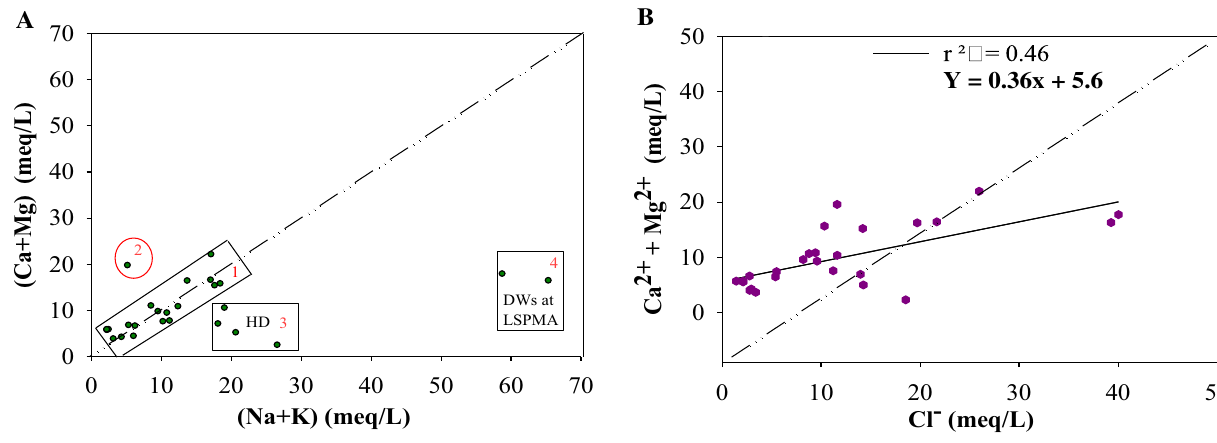
Fig. 5 a A plot of (Na ? ? K ? ) vs. (Ca 2 ? ? Mg 2 ? ), b A Plot of (Na ? ? K ? )